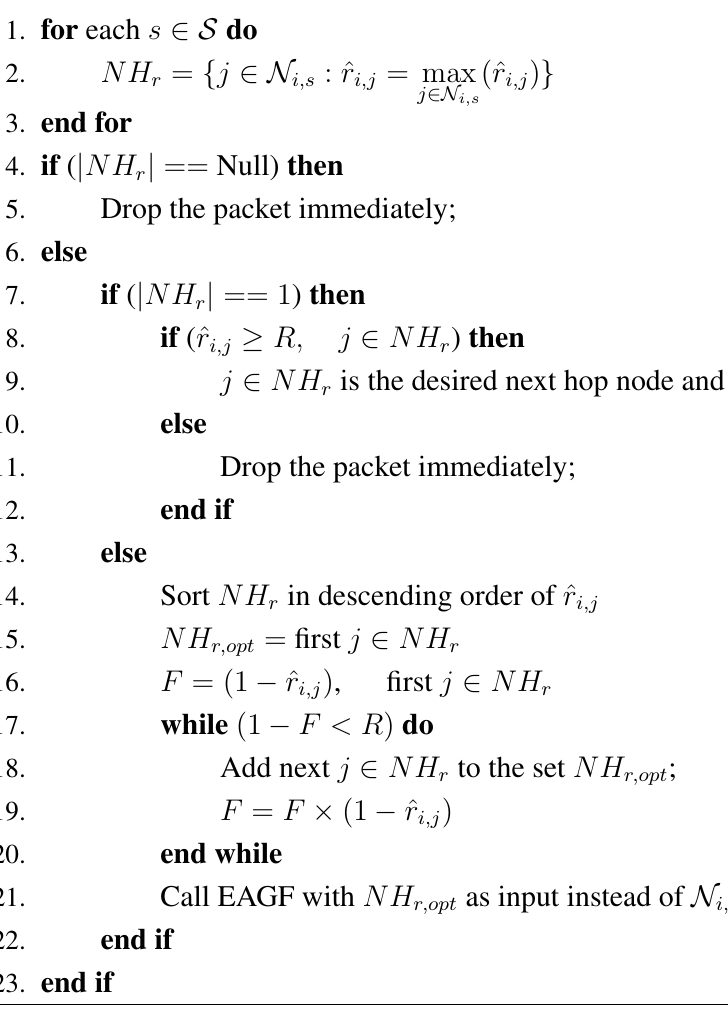
Algorithm 1 Reliability Control Algorithm, at each source node i